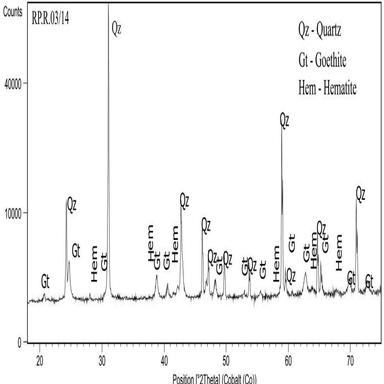
X-ray diffraction (XRD) pattern of the FSS in the Vicente locality near the Pedreira River (sample RP.R.03/14), in which the domain quartz, goethite, and restricted hematite are identified.